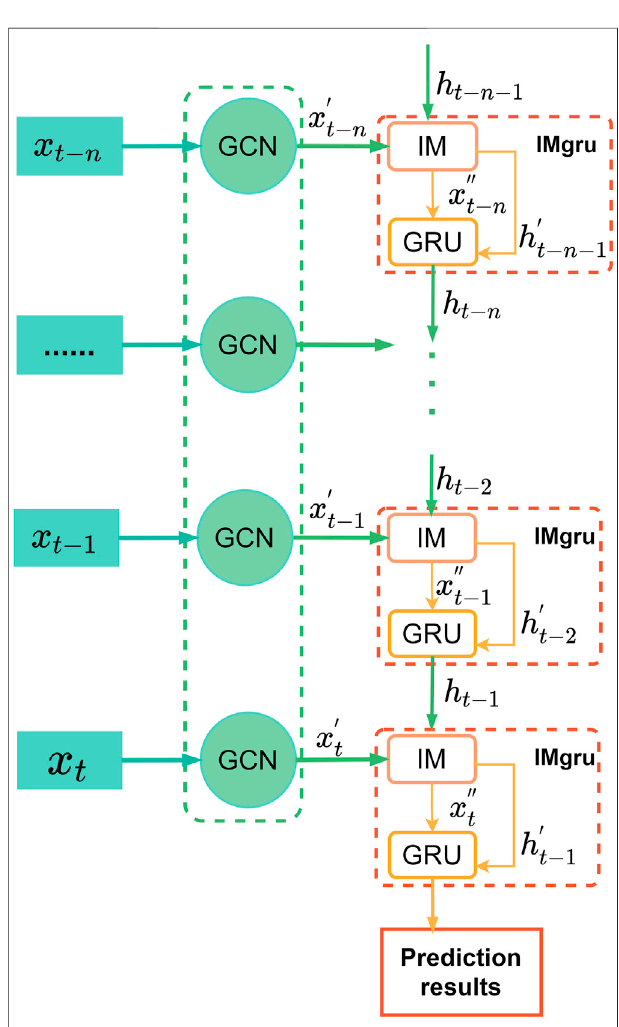
FIGURE 7 | IMgruGcn model